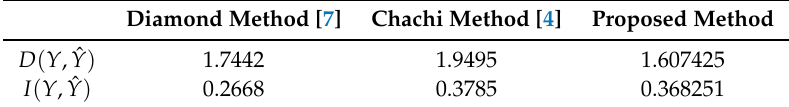
Table 5. The comparison of performance measures for Example 1.